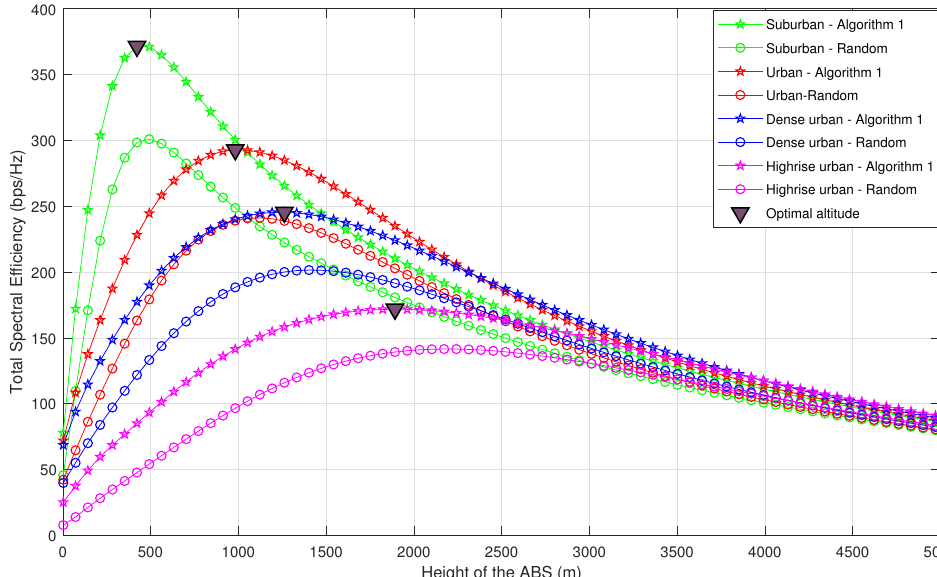
Figure 6. Total spectral efficiency vs. altitude of the ABS (comparison between Algorithm 1-based deployment and random deployment).